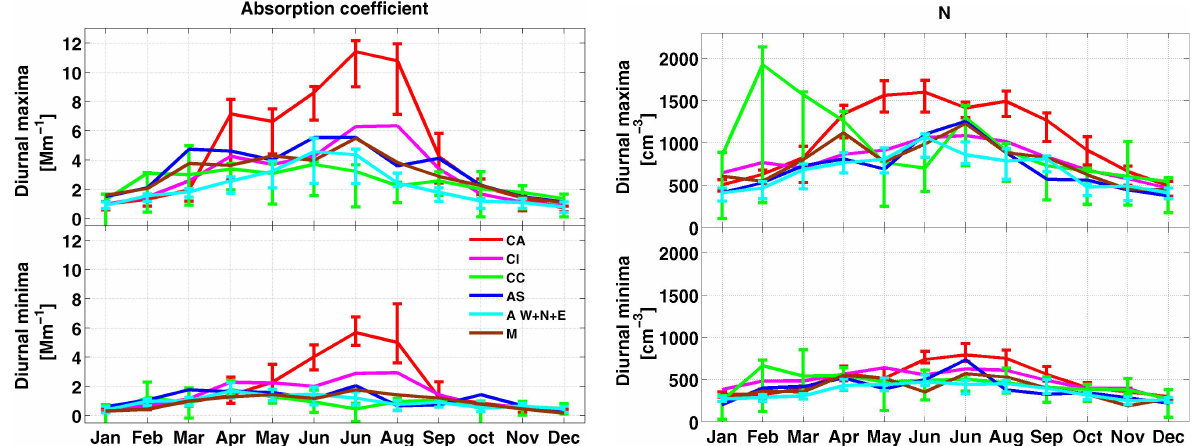
Fig. 11. Monthly diurnal maxima and minima of b abs and N as a function of SYNALP weather types. Error bars correspond to non- parametric confidence limits.